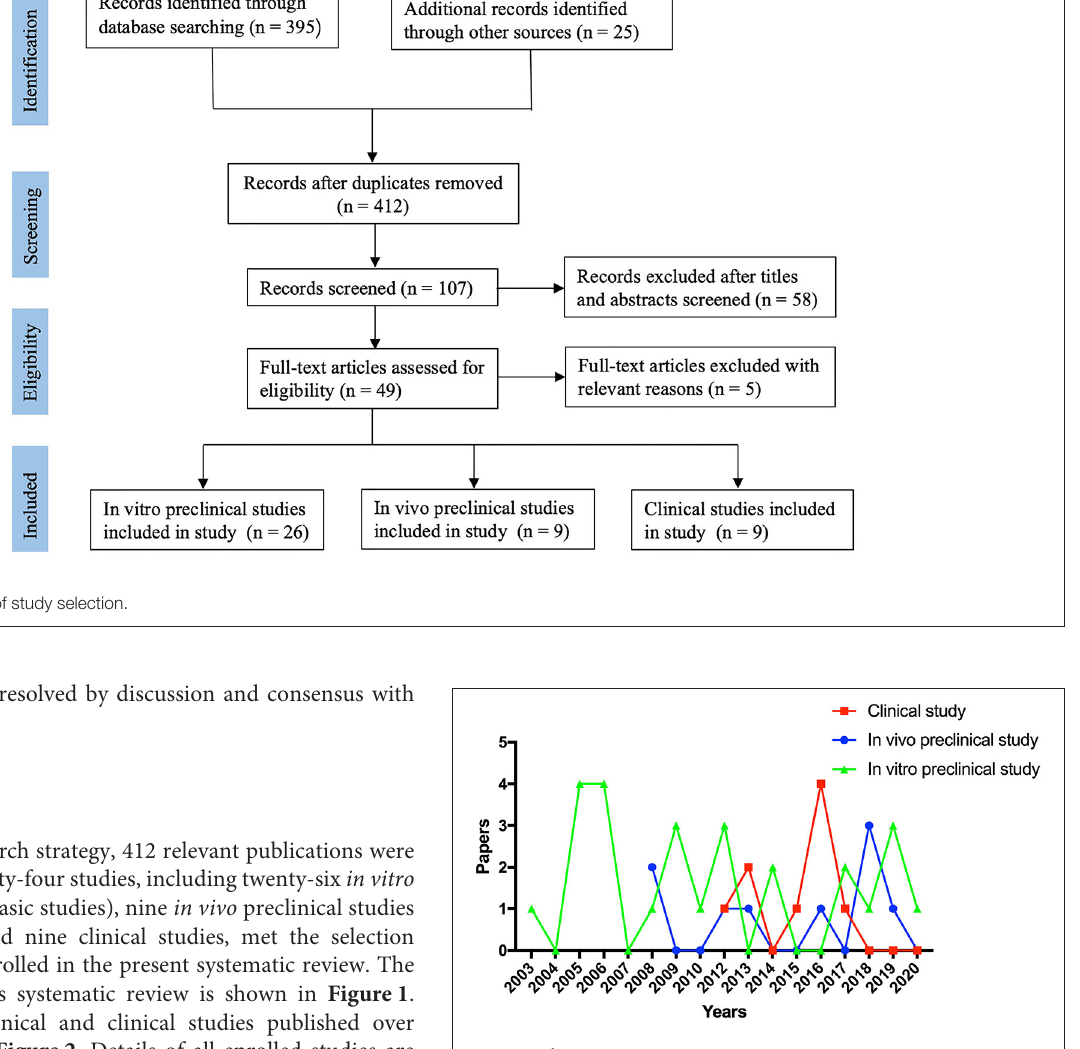
FIGURE 2 | The trend of preclinical and clinical studies published over